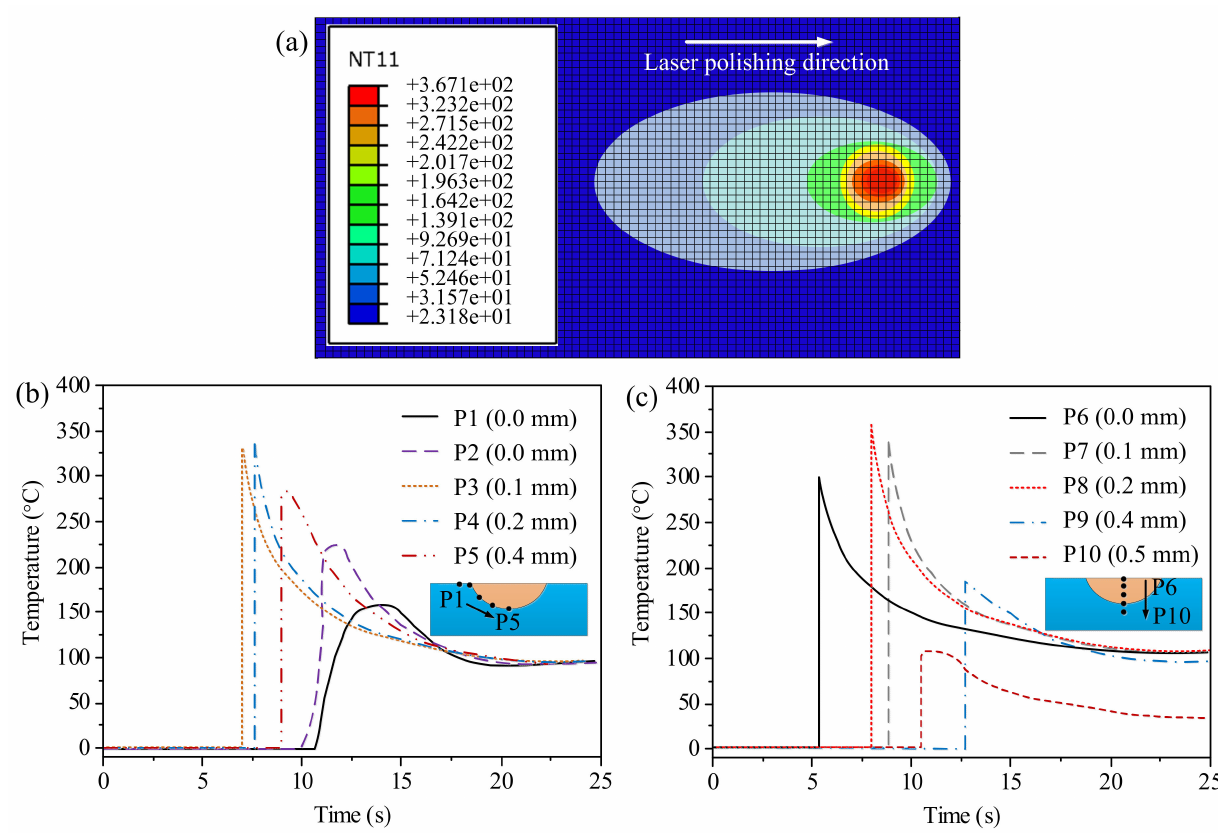
Figure 3. Numerical simulation and thermodynamic analysis of FDM-fabricated PLA using laser polishing: ( a ) Temperature field simulation; ( b ) temperature profiles at different depths on the surface of molten pool; ( c ) temperature profiles at different depths on the center of molten